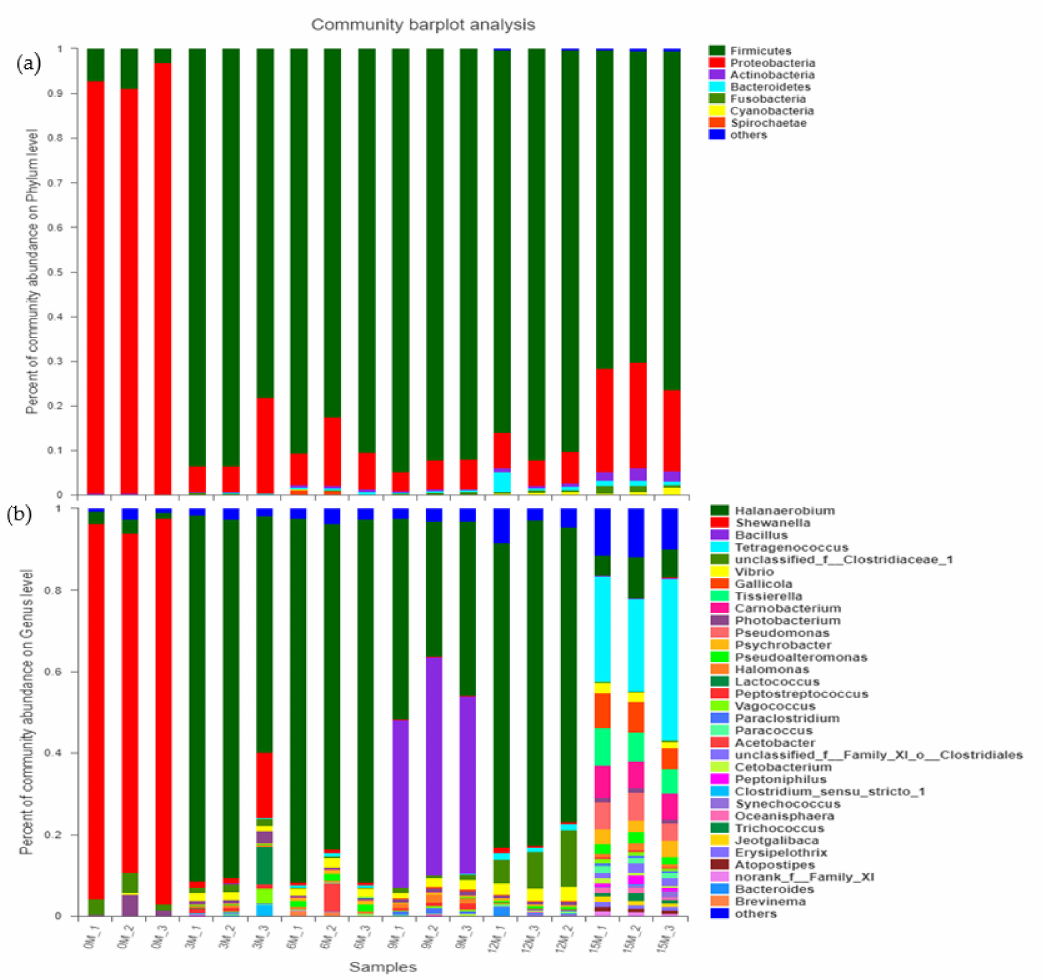
Figure 6. Stacked-column analysis of relative abundances of bacterial communities in fish sauce at di ff erent fermentation stages at the phylum ( a ) and genus ( b )